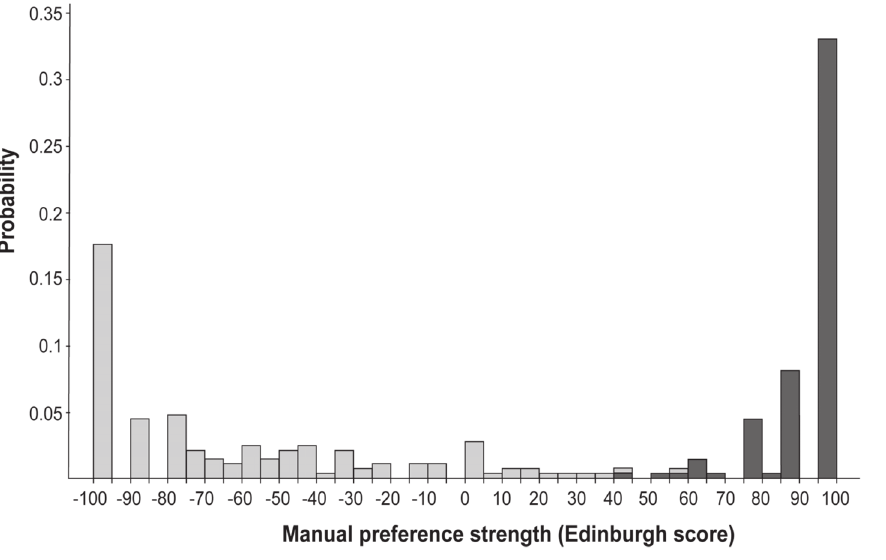
Figure 1. Histogram distribution of the manual preference strength variable assessed by the Edinburgh inventory score. Self- reported left- (resp. right-) handers correspond light (resp. dark) grey bars.